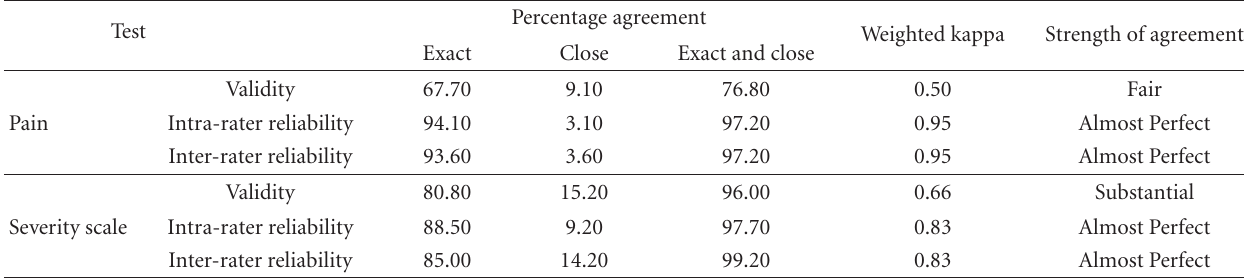
Table 5: Results from the analysis of physical examinations producing categorical